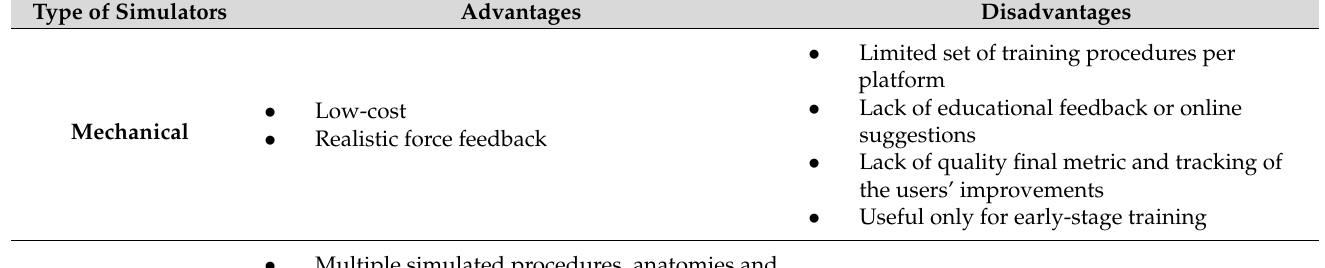
Table 1. Advantages and disadvantages of each